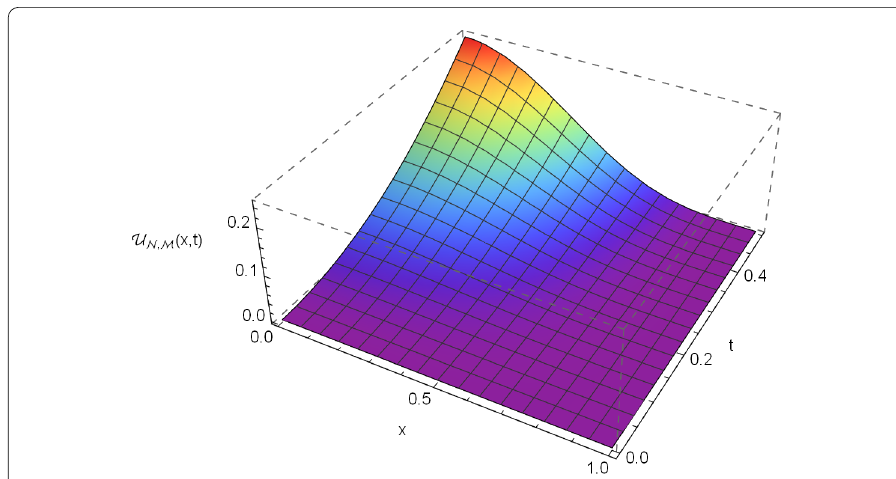
Figure 1 U N , M of Eq. (1) with δ = 1.8, N = 8, M = 2